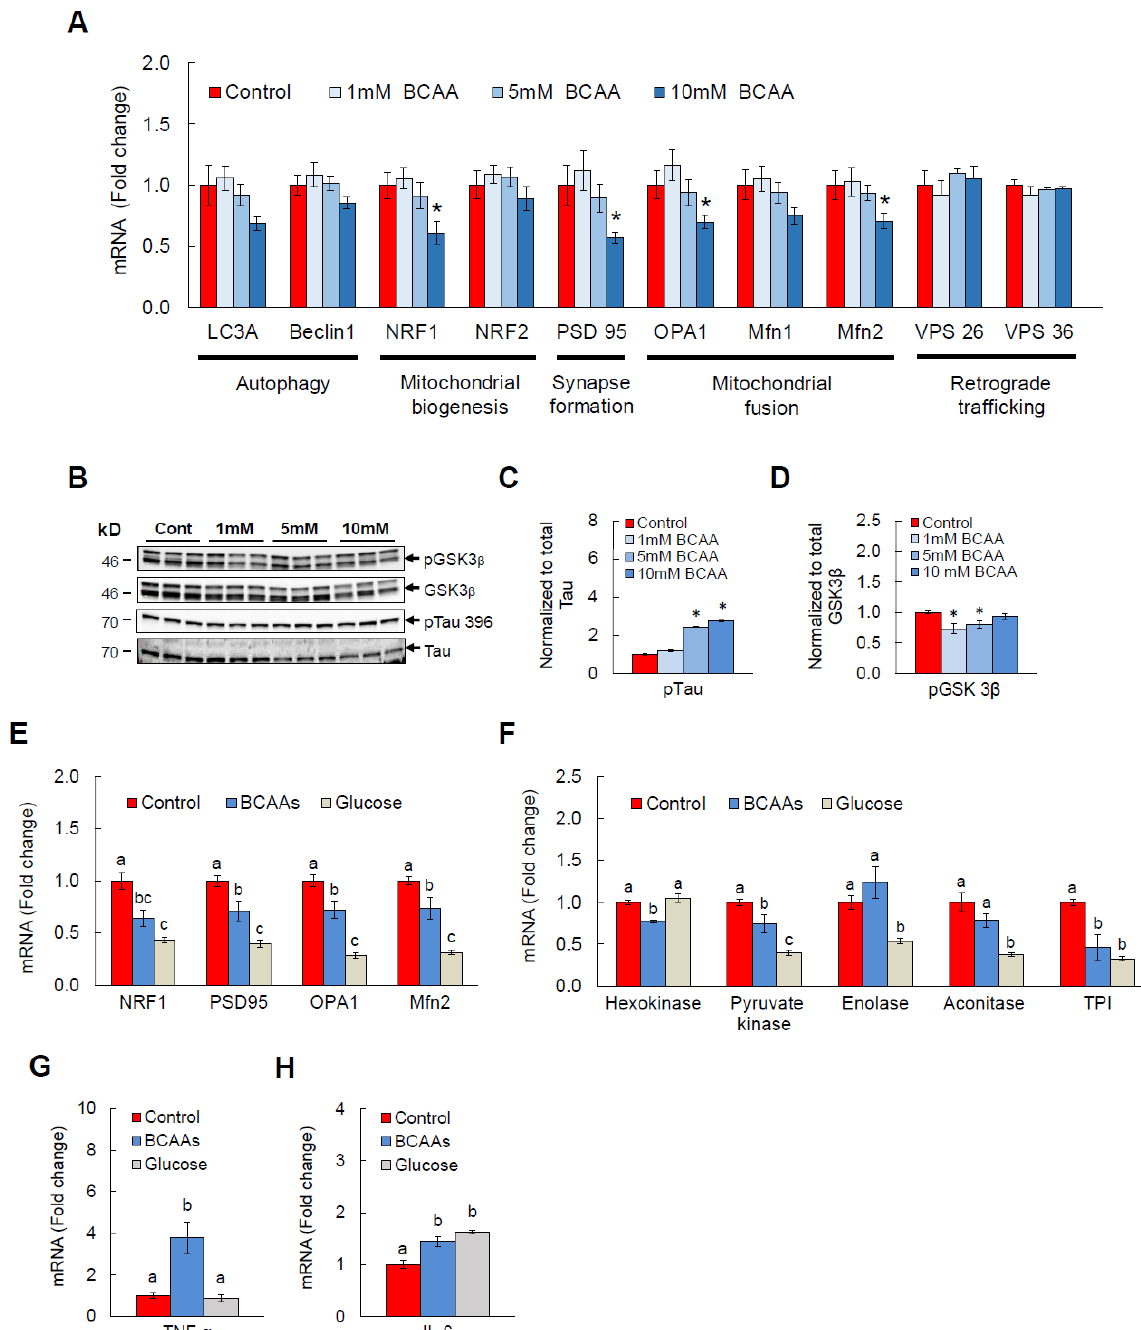
Figure 3. BCAA treatment induces AD-related changes in vitro. Differentiated HT-22 hippocampal neurons were supplemented with a mixture of BCAAs in the culture media for 24 h. ( A ) mRNA expression of genes involved in autophagy, mitochondrial biogenesis and fusion, synapse formation, and retrograde trafficking. ( B ) Western blots showing pGSK3 β , total GSK3 β , pTau 396, total Tau. ( C ) Analysis of Tau phosphorylation at residue 396 and ( D ) pGSK3 β . ( E – H ) In a separate cohort, differentiated HT-22 neurons were exposed to either vehicle or 10 mM BCAAs in the media for 24 h. Another group was exposed to 25 mM glucose to induce glucotoxicity, a widely used neurotoxicity model, as a comparison. ( E ) mRNA levels for neuronal health genes as described above were analyzed. ( F ) Genes critical for glycolytic pathway. ( G ) mRNAs of TNF- α and ( H ) IL-6. All mRNAs were normalized to B2M. n = 6/group; * p < 0.05 compared to Control. Groups with different letters (i.e., a, b, c) are significantly different from each other with p < 0.05.